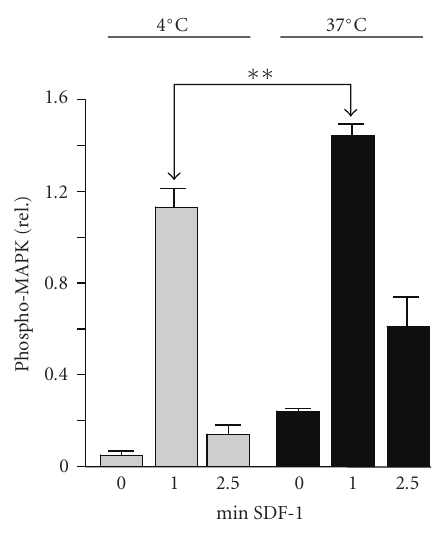
(d) Quantitive analysis of the Western blots by densitometry ( n = 3, ∗∗ P < . 01, aged PMN at 37 ◦ versus cells kept at 4 ◦ C to prevent aging)